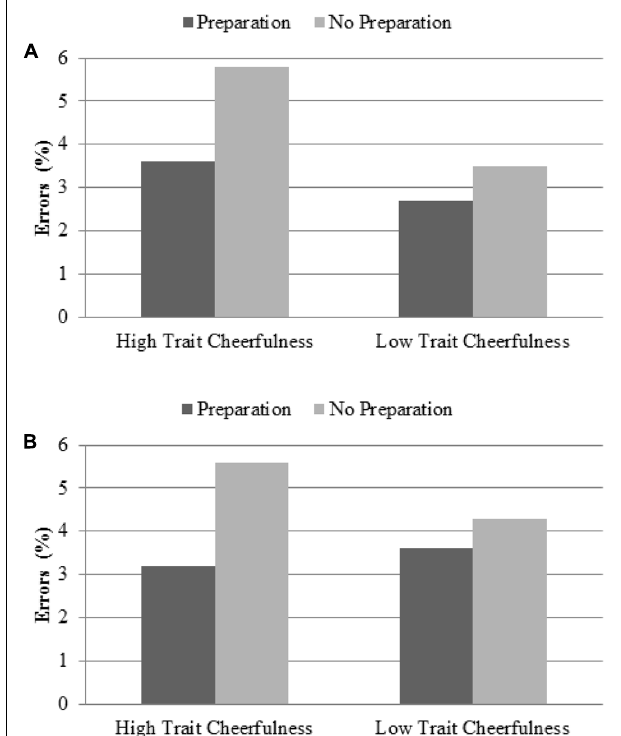
FIGURE 4 | Effect of preparation as a function of the trait cheerfulness group for: (A) Study 1; and (B) Study 2, preparation part. Both graphs reveal that participants with high trait cheerfulness showed a higher effect of preparation than those with low trait cheerfulness, measured as a greater reduction in error percentage when the target was preceded by a signal that anticipated the upcoming demand than when it was not